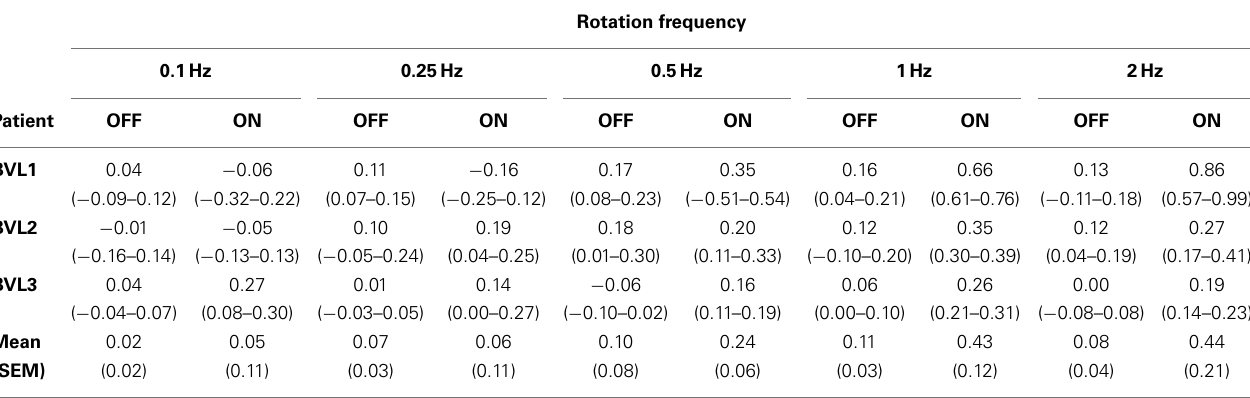
Two stimulation conditions are compared: system OFF and system ON (modulation strength corresponding to 50% of each patient’s dynamic range). Values given per patient are median (calculated over 21 cycles); 25th–75th range given in parentheses. SEM, standard error of the